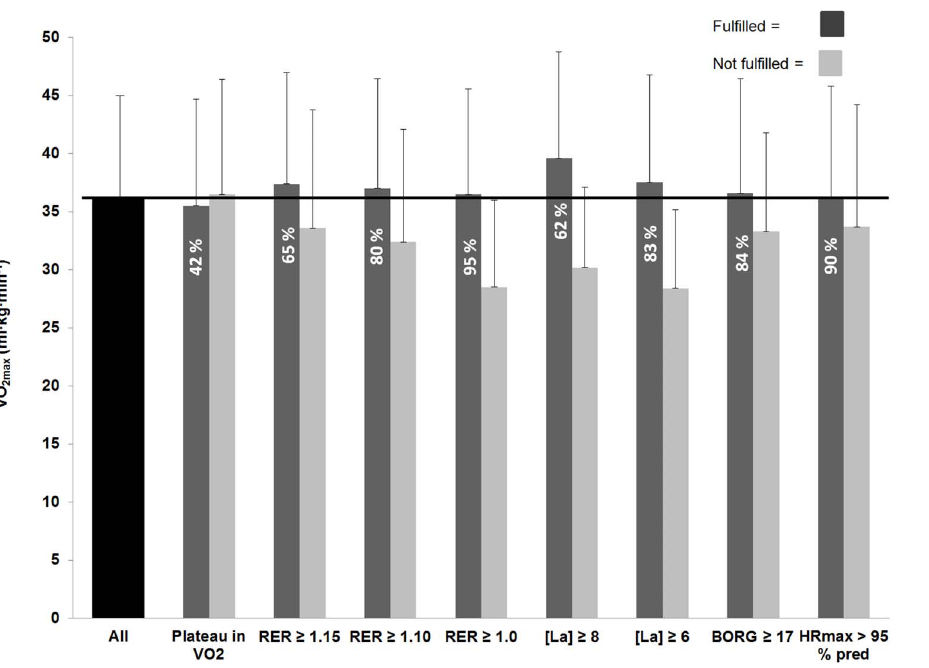
Figure 1. Maximal oxygen uptake (VO 2max ) using different end criteria (dark grey) compared to volitional fatigue (all) (mean 6 SD). The light grey bars show VO 2max in those subjects who did not fulfilled the end criterion. The % of participants who fulfilled the criterion is reported on each bar.